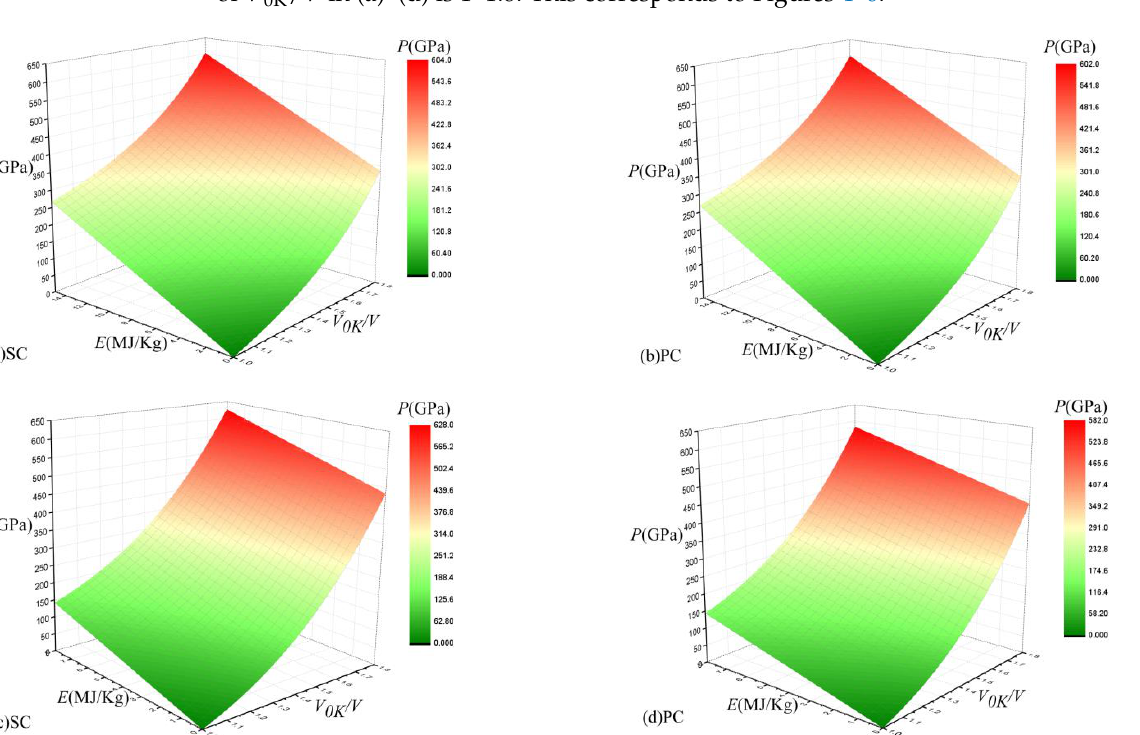
Figure 8. Mie–Grüneisen equation of state in P - E - V space, where ( a , b ) use the Hugoniot curve as a reference, and ( c , d ) use the cold curve as a reference.